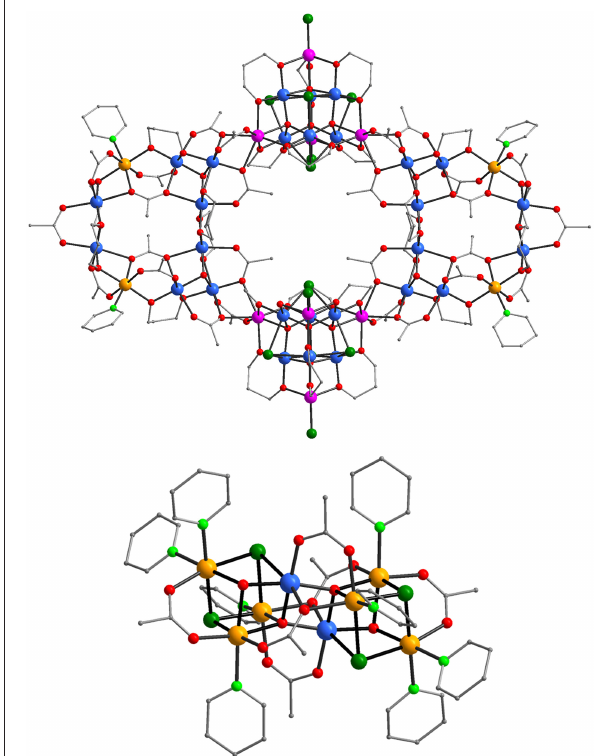
FIGURE 1 | Representations of the molecular structures of the [Mn 36 Ni 4 ] 2 − anion (top) and the [Mn 2 Ni 6 ] 2 + cation (bottom) of 1 Color code: Mn II purple, Mn III blue, Ni II orange, O red, N light green, Cl green, C gray. H atoms are omitted for clarity.